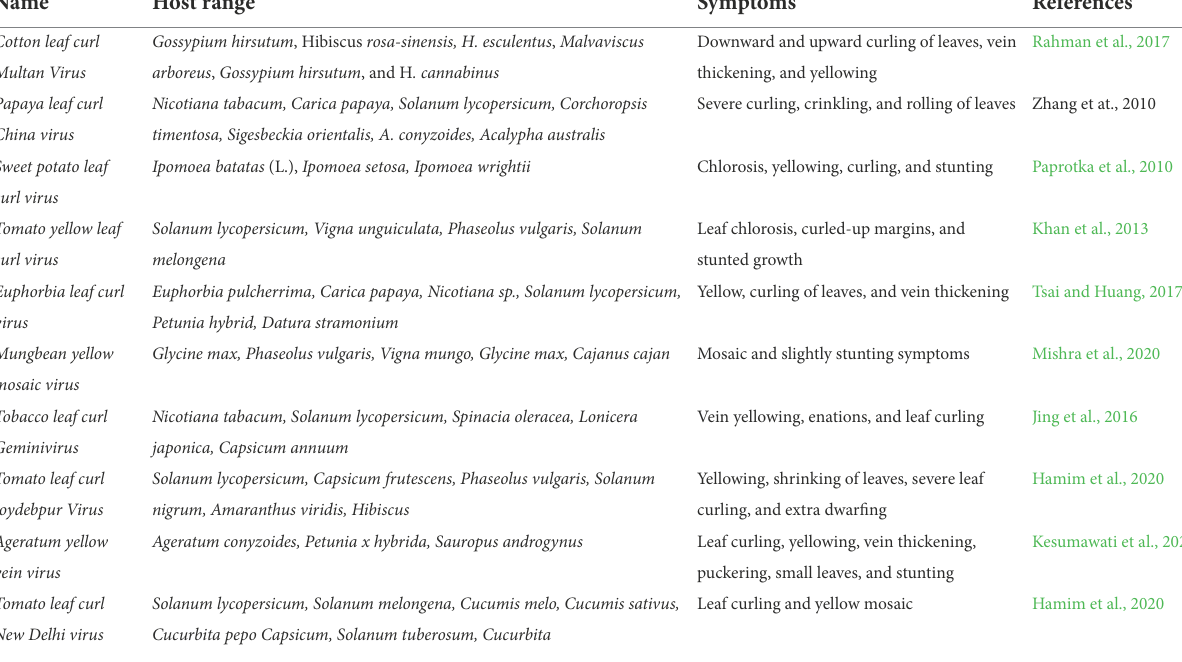
TABLE 2 Host range and symptoms of certain destructive begomoviruses in the